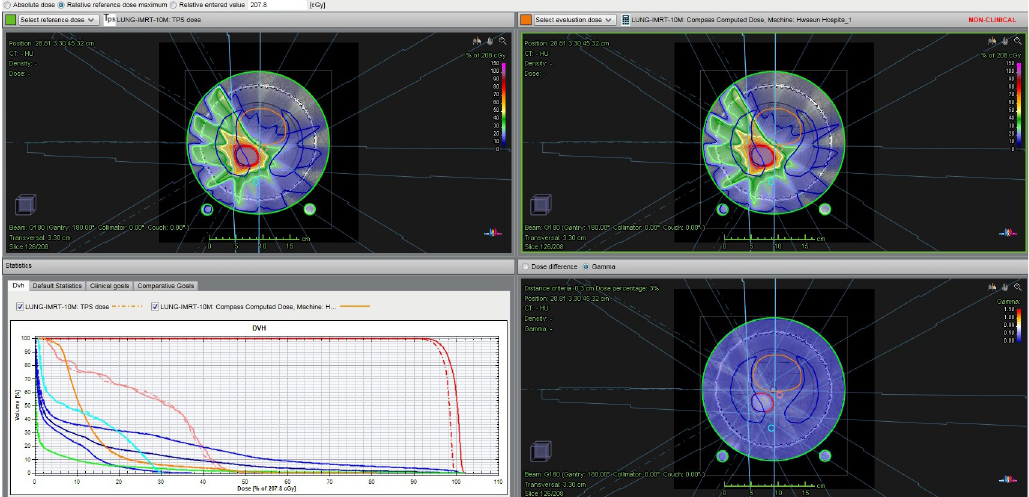
Fig 2. Example of the result of the recalculated dose distribution using the compass program.